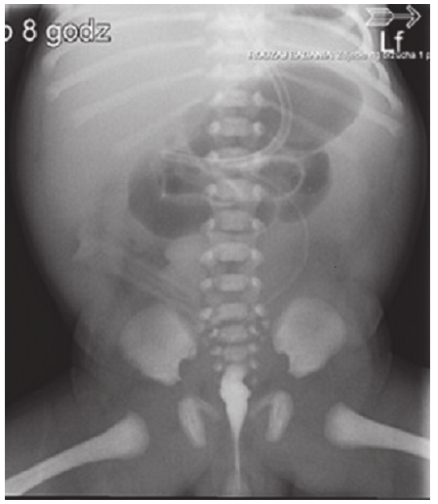
Figure 2: Barium enema revealed microcolon.